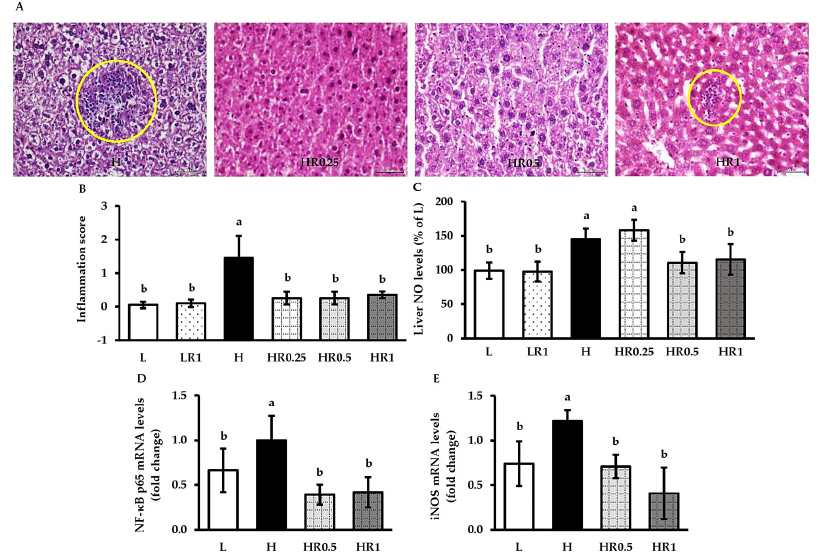
Figure 4. Effects of RRBE on hepatic inflammatory markers in mice fed with experimental diets: ( A ) representative photomicrographs of H and E-stained liver sections showing the presence of inflammatory cell foci (yellow circles; × 400 magnification, bar length = 50 µ m); ( B ) inflammatory score; ( C ) liver NO levels; ( D ) liver NF- κ B p65 mRNA levels; ( E ) liver iNOS mRNA levels. Values are means ± SD; 6 mice/group. Statistically significant difference at p < 0.05 was analyzed using one-way ANOVA with Tukey’s test and is indicated by different letters above error bars. The L, LFD, and distilled water co-treated group; LR1, LFD, and high-dose (1 g/kg) RRBE co-treated group; H, HFD, and distilled water co-treated group; HR0.25, HFD, and low-dose (0.25 g/kg) RRBE co-treated group; HR0.5, HFD, and middle-dose (0.5 g/kg) RRBE co-treated group; HR1, HFD, and high-dose RRBE co-treated group.